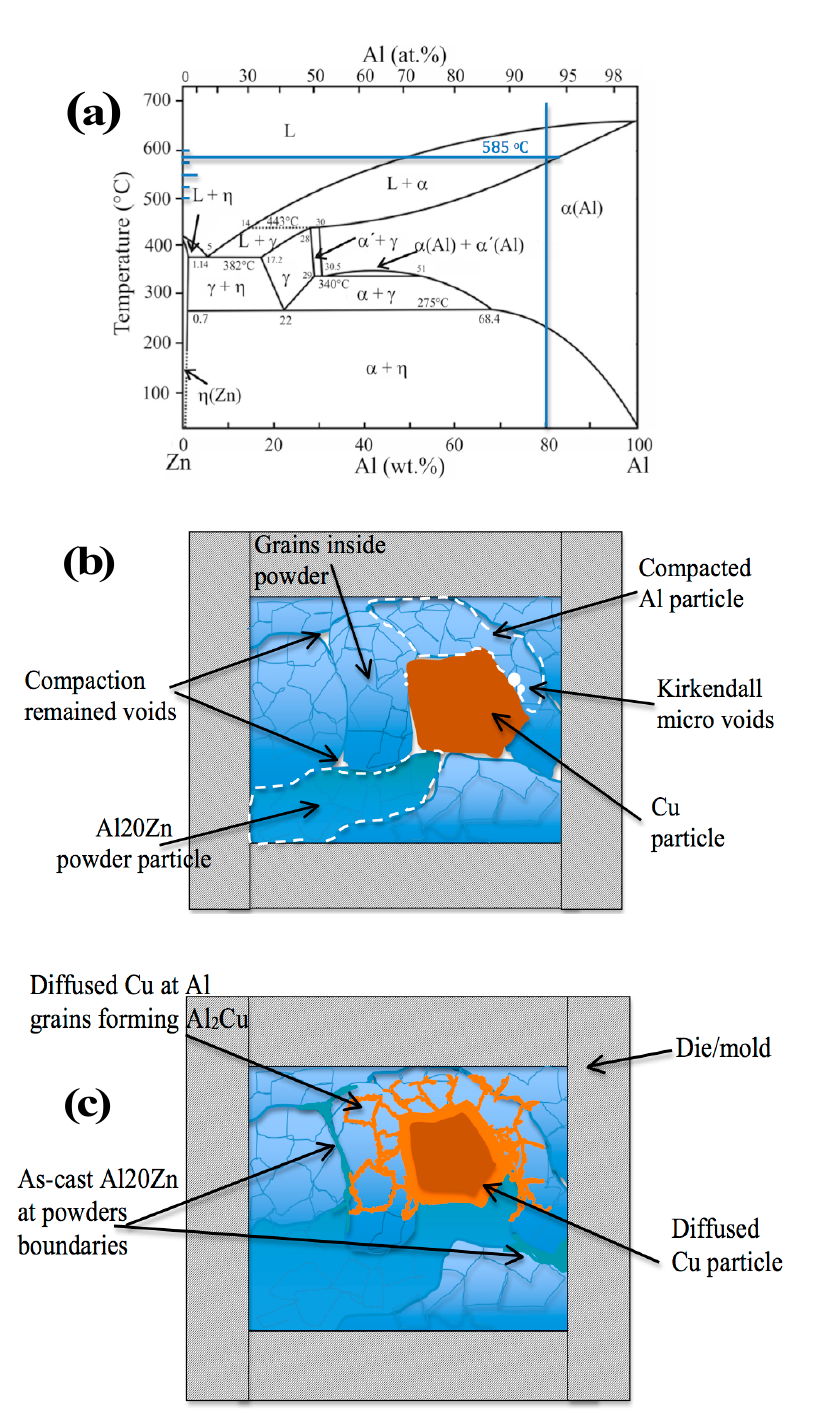
Figure 6. ( a ) Binary Zn-Al phase diagram; ( b ) schematic representation of the compacted and sintered powders at 585 ◦ C; ( c ) evidence of the diffused Cu particles forming Al 2 Cu intermetallic constituents and the accommodation of liquid phase (as-cast) boundary powder particles.